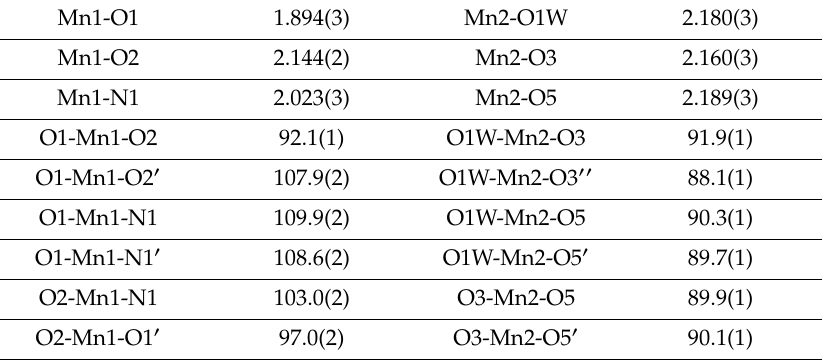
Figure 3. Partially labeled representation of the [Mn 2 (sacb) 2 (H 2 O) 2 (MeOH) 2 ] + repeating unit of the 1-D polymer 2 . Color scheme: Mn III , blue; Mn II , yellow; Cl, purple; O, red; N, green; C, gray. H atoms are omitted for clarity. Primed and unprimed atoms are related by symmetry. The arrows indicate the O atoms, which are responsible for the polymerization of the dinuclear repeating units. Table 3. Selected interatomic distances (Å) and angles ( ◦ ) for the 1-D polymer 2 · H 2 O a